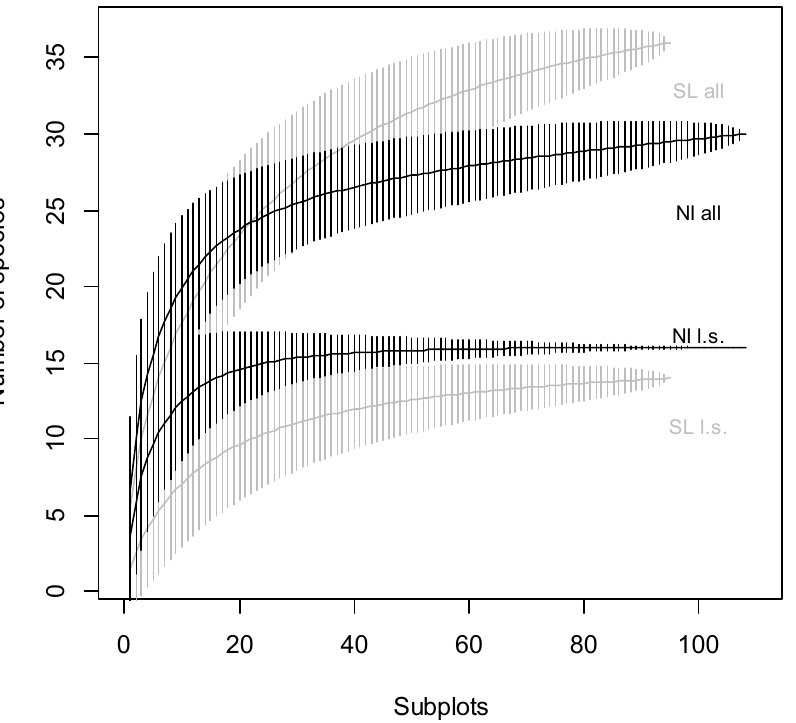
Figure 2. Species accumulation curves [47] for salvage-logged (SL) and non-intervention (NI) sites using two species groups; i.e., late successional species (l.s.) and all species (all). Vertical lines indicate confidence intervals estimated by the first order jack knife method; i.e., “all” refers to all species used while “l.s.” indicates late successional species.